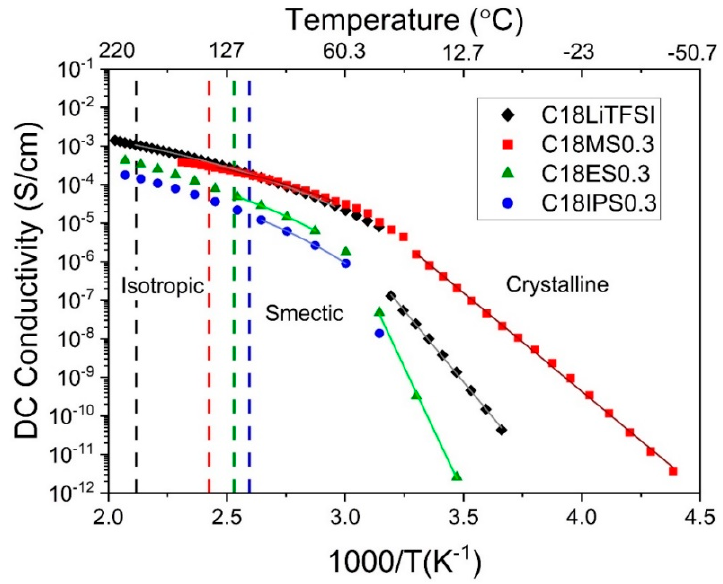
Figure 7. DC conductivity of 0.3:1 C18RS:C18LiTFSI ratio across temperatures compared to C18LiTFSI. The isotropic to smectic transitions as measured using DSC are indicated for each material by vertical lines, and regressions calculated based on Arrhenius or VTF models are displayed as fit lines. Data for C18LiTFSI were originally reported in [21].